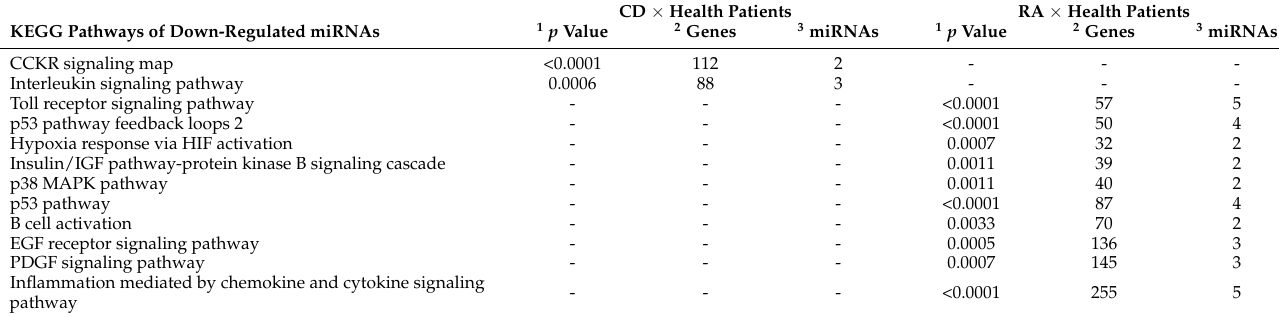
Table 3. Enriched pathways from target genes of down regulated miRNAs from CD and RA compared to healthy